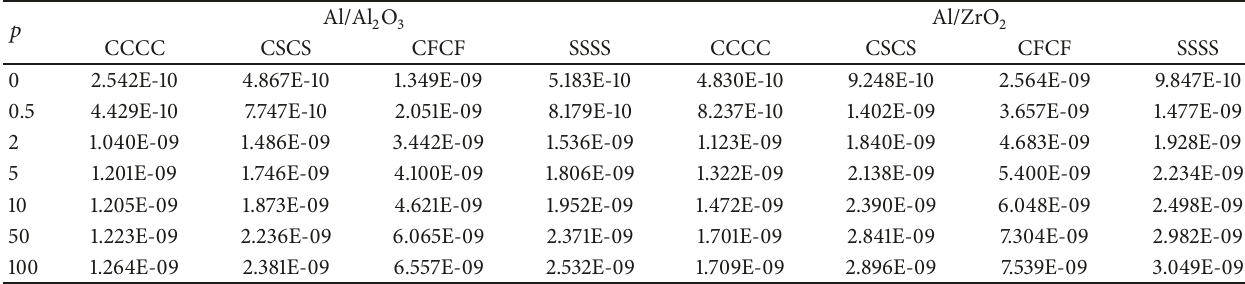
Table 5: Maximum deflection W for FG plates having various boundary conditions with the central point load. 𝑝